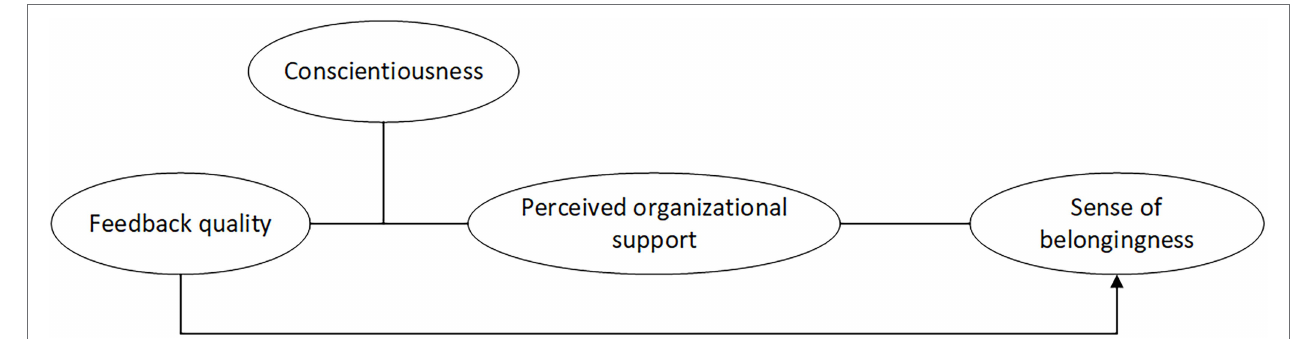
FIGURE 1 | The research